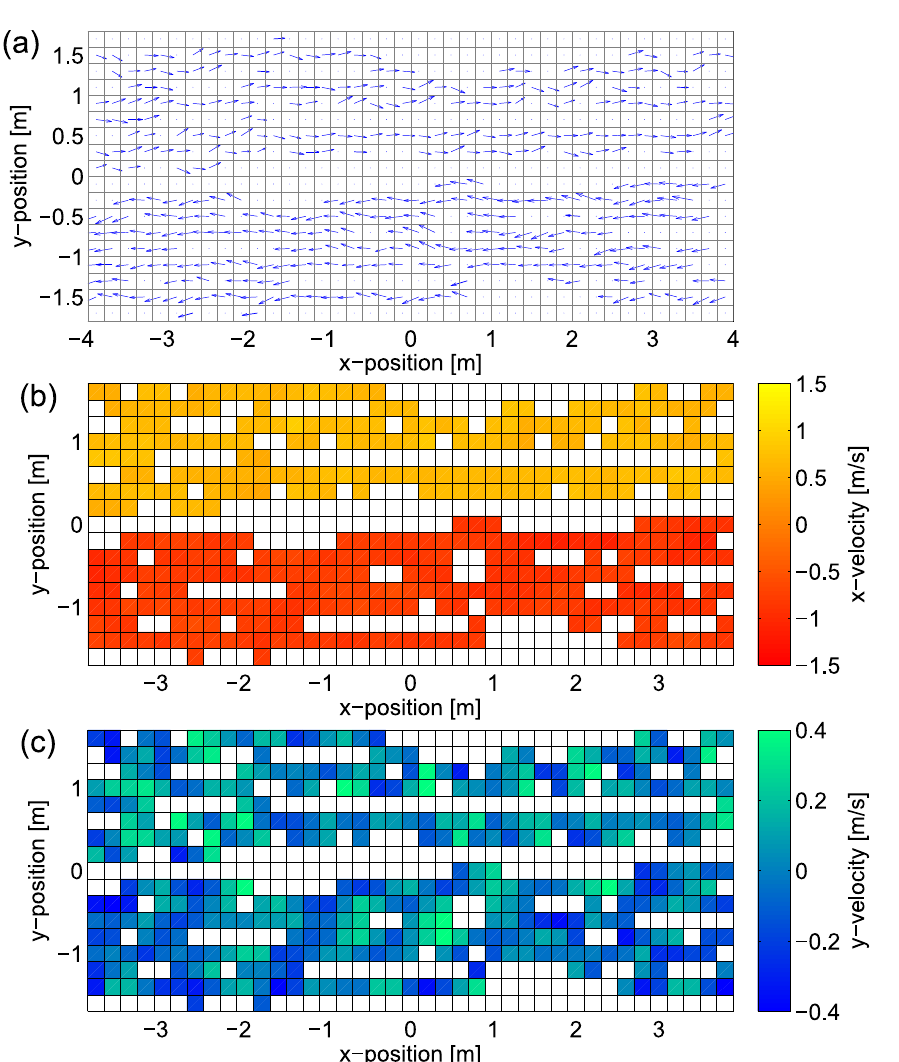
Fig 6. Velocity representation of bidirectional streams. Different ways of representing pedestrian speed in the bidirectional flow; the example provided here corresponds to one experiment of dataset D, figures are generated for a 2.5 s time interval and a 0.2 m mesh size. The 3 representations are: (a) vector field, (b) x -velocity (direction of motion) and (c) y -velocity (lateral